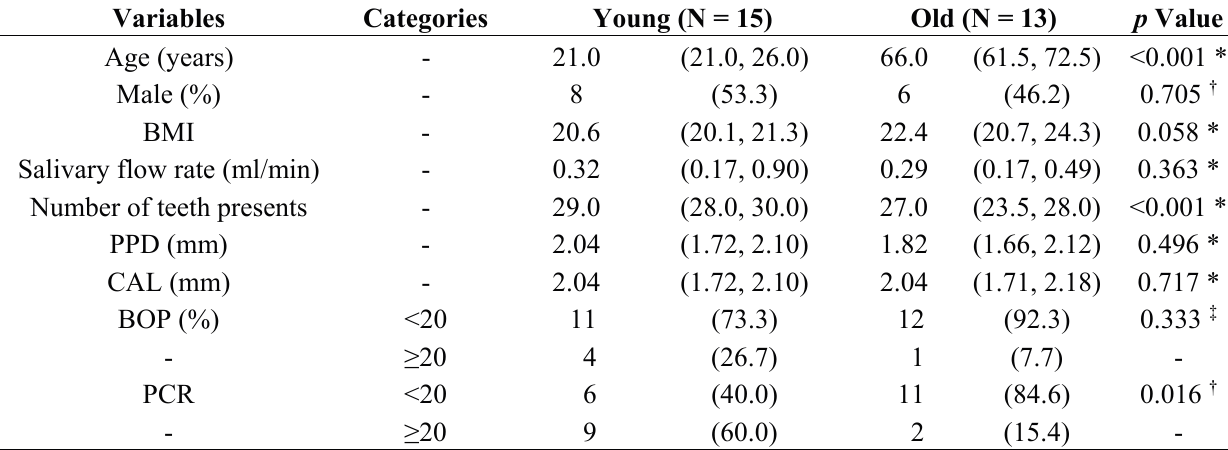
Table 1. Characteristics of young and old groups (median (25th, 75th percentile) or N